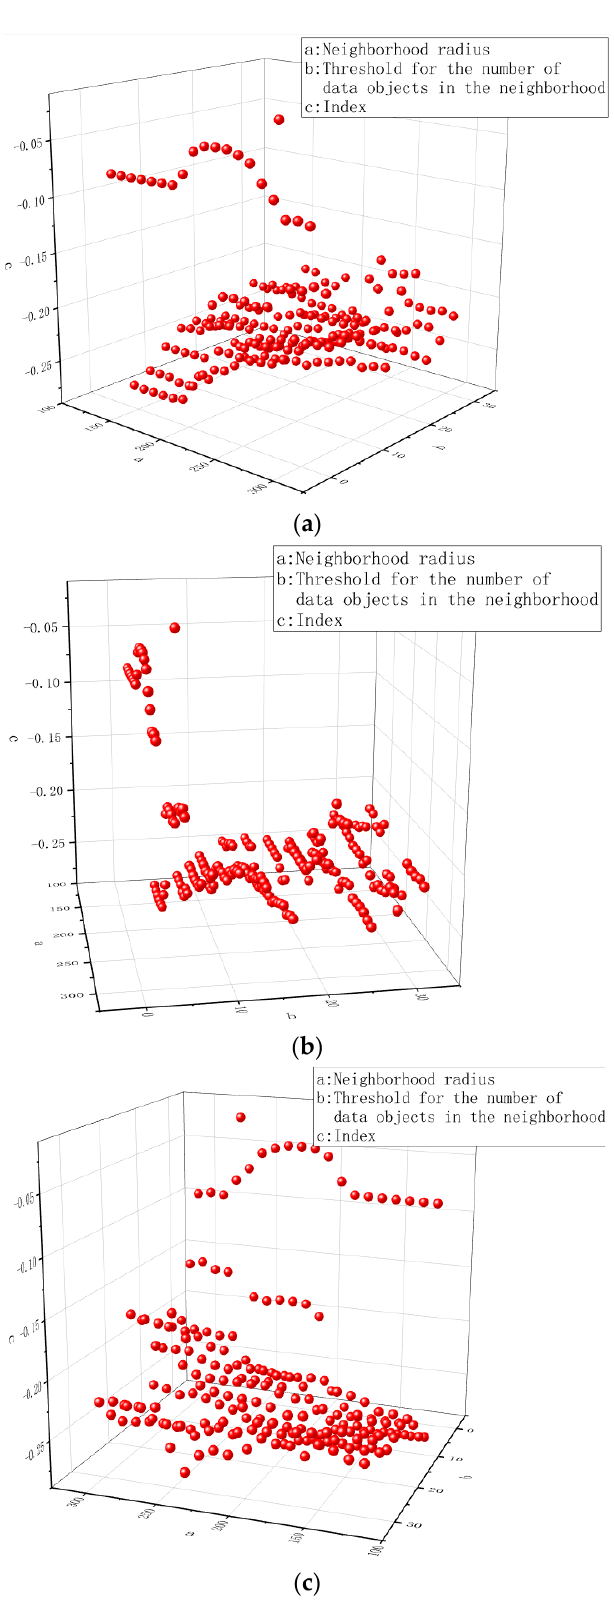
Figure 7. ( a ) The influence of the neighborhood radius and the threshold of the number of data objects in the neighborhood on the indicators of the DBSCAN algorithm. ( b ) shows the effect of thresholds on the number of data objects in the neighborhood on performance metrics. ( c ) shows the effect of neighborhood radius on the effect